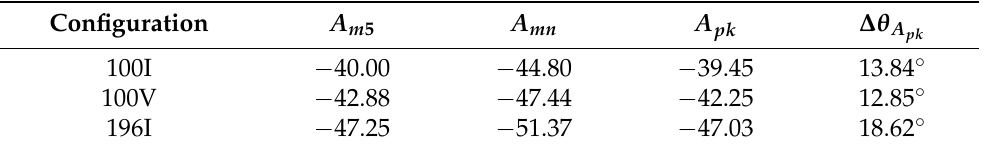
Table 4. Summary of the beampattern parameters for the best solutions at each configuration. Combined fitness